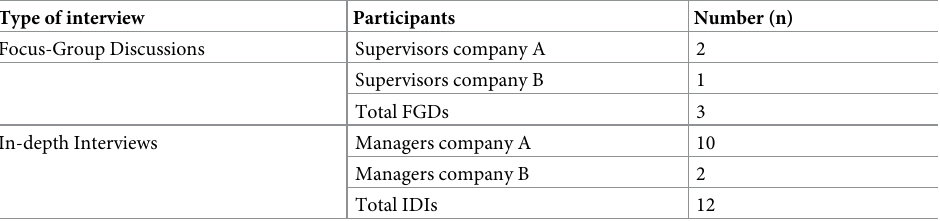
Table 1. Type and number of qualitative interviews